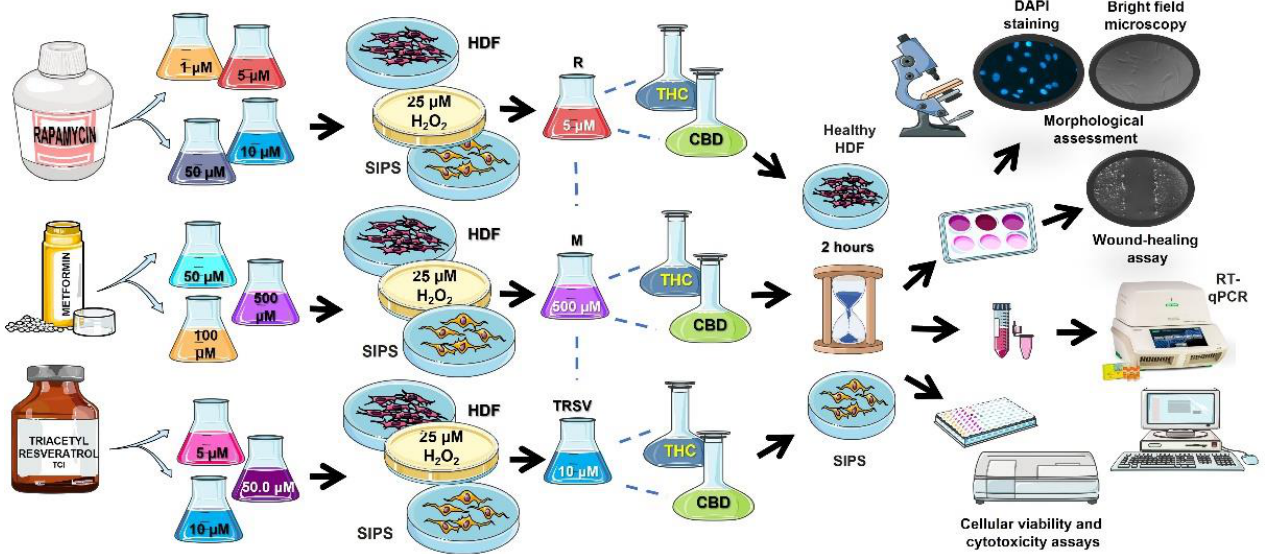
Figure 1 . Testing of different concentrations of anti-aging drugs on prematurely senescent dermal fibroblasts. The figure shows steps to discover the efficient dose in treating senescent fibroblasts among three popular anti-aging drugs: rapamycin (R), metformin (M), and triacetylresveratrol (TRSV). CBD, cannabidiol; HDF, human dermal fibroblasts; H 2 O 2 , hydrogen peroxide; SIPS, stress- induced premature senescence; THC, Δ -9-tetrahydrocannabinol. Dashed lines show a combination of treatments. This figure was created using images from Servier Medical Art Commons Attribution 3.0 Unported License (http://smart.servier.com (accessed on 26 September 2020)).